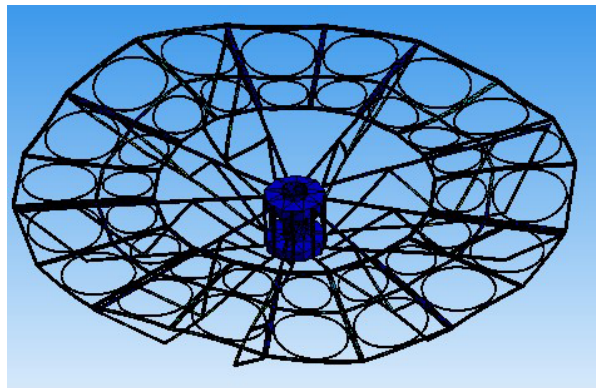
Figure 24. The fourth-order mode shape of the optimized free vi-